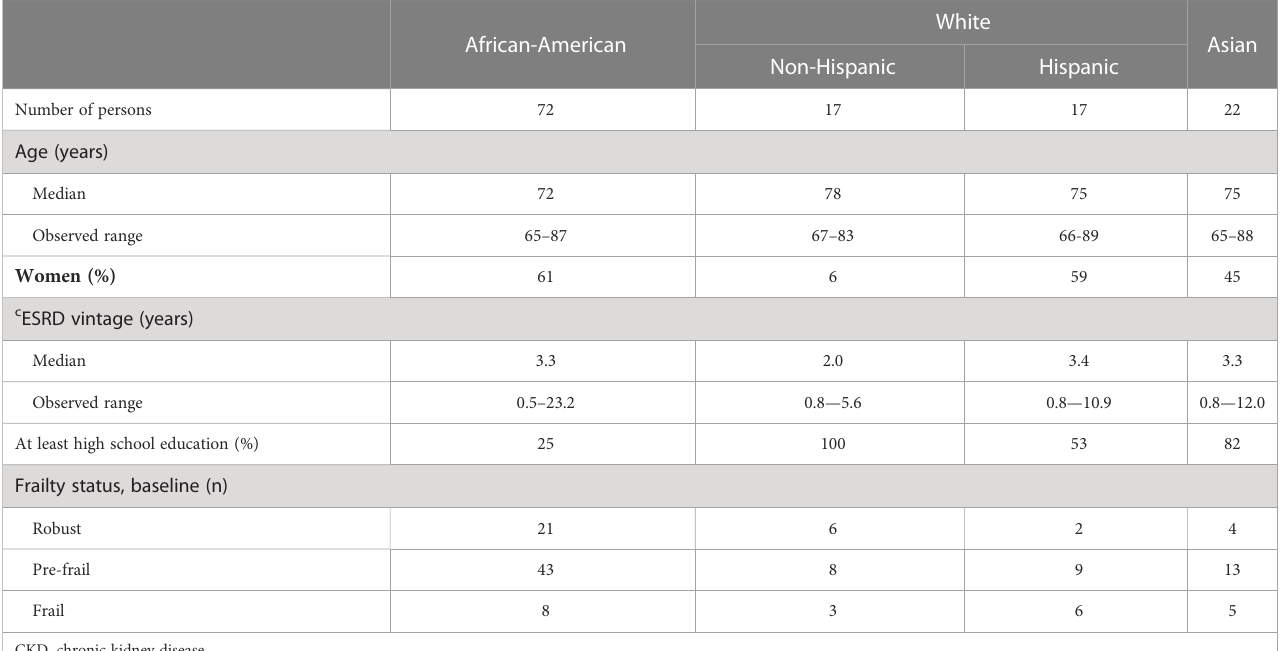
TABLE 2 Baseline characteristics of older persons with dialysis-dependent CKD who were eligible a for this study, strati fi ed by race and ethnicity b